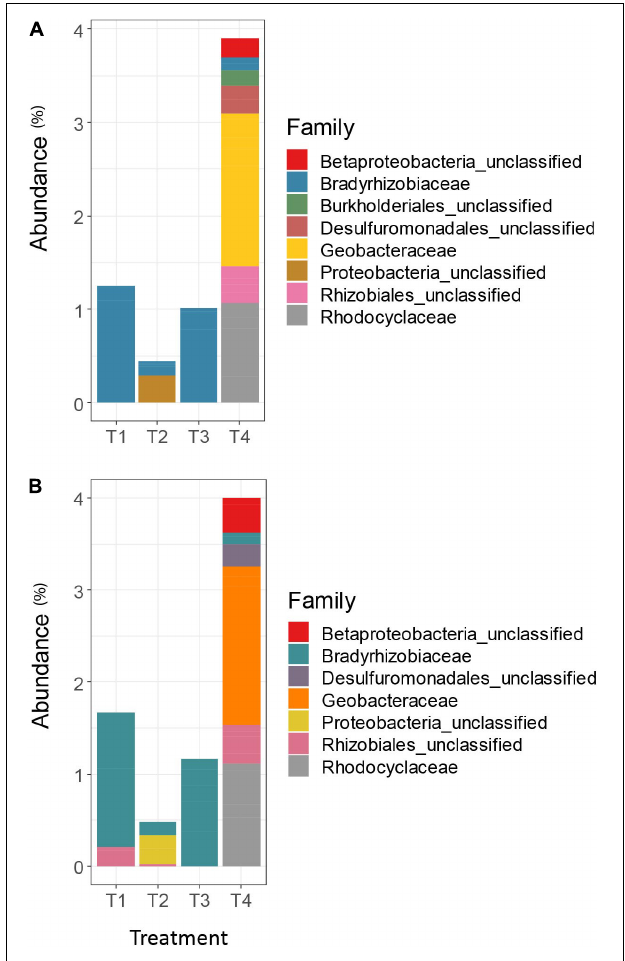
FIGURE 3 | Differentially abundant nifH taxa among the top 100 OTUs for the AGC-0.03 method (A) and the MCC-0.03 method (B) . Significance of differential abundance assessed at α = 0.01.